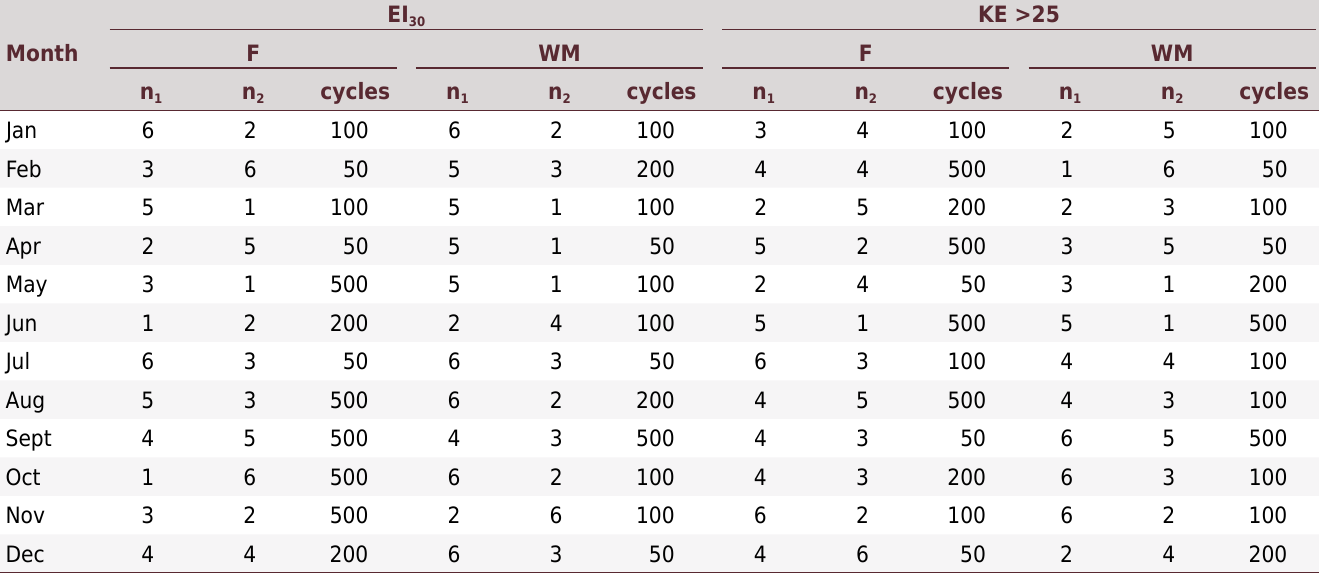
Table 2. Number of neurons in the intermediate layers and training cycles of the artificial neural networks developed for monthly estimate of rainfall erosivity in the state of Rio Grande do Sul according to the EI 30 and KE >25 erosivity index and the methods for obtaining the kinetic energy of rainfall (F and WM)